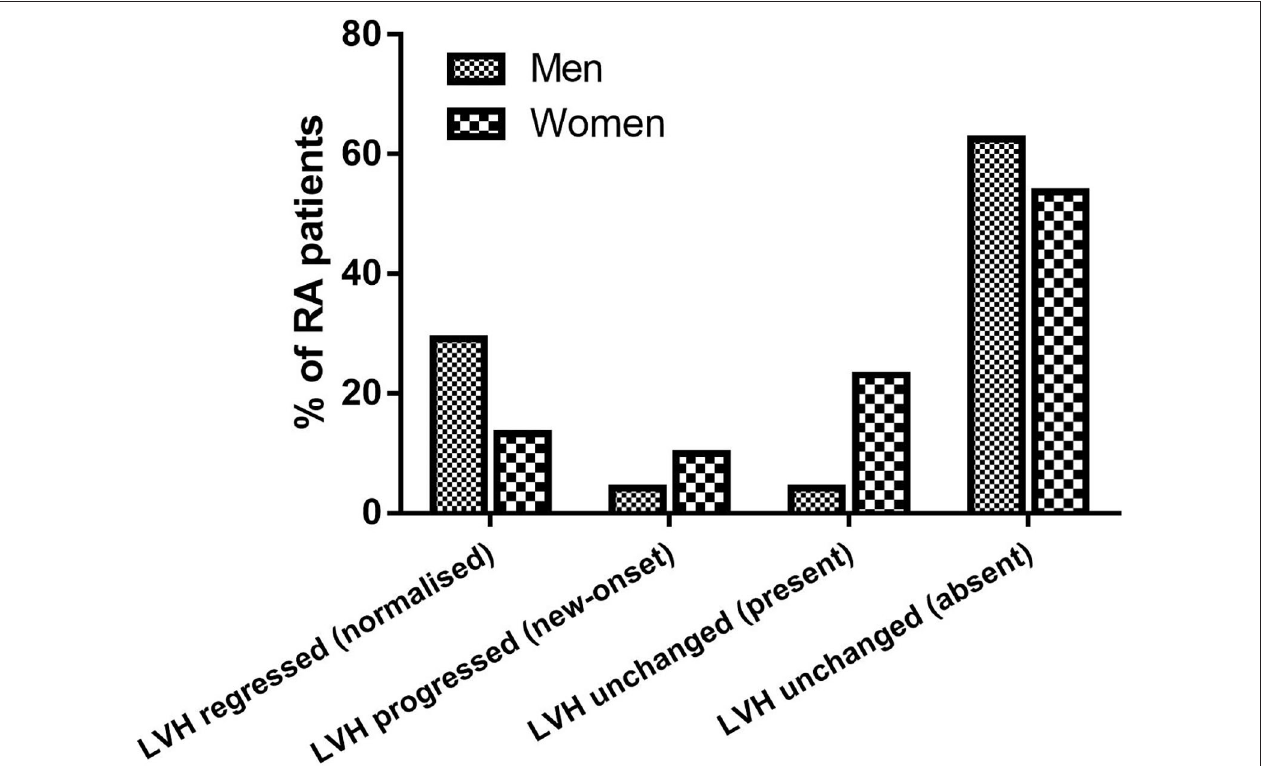
FIGURE 1 | Proportions of RA patients showing LVH regression, LVH progression, and stable LVH at follow-up.